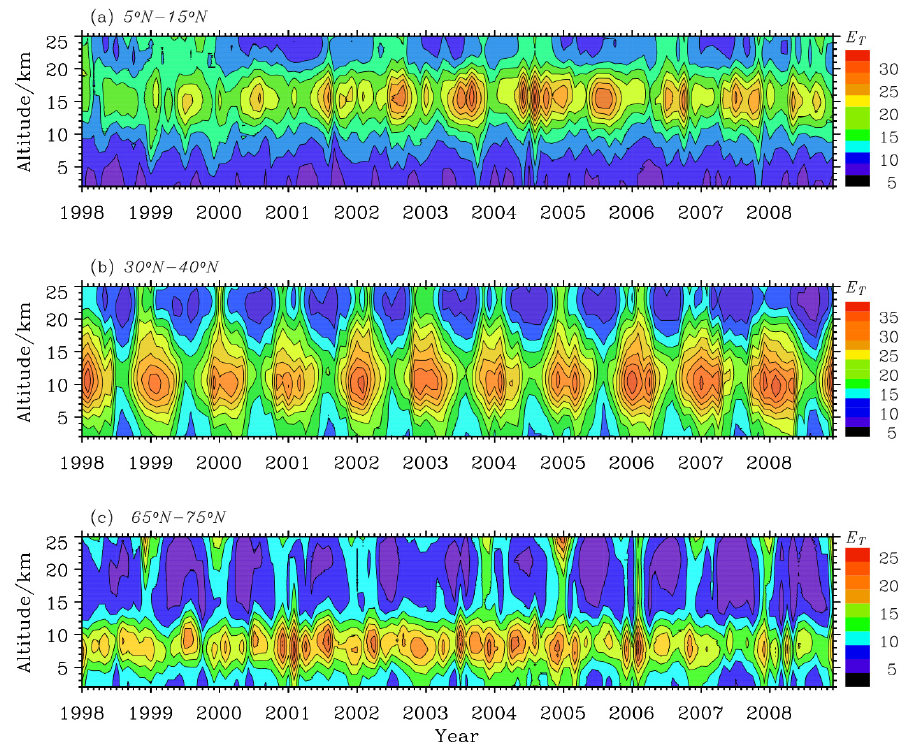
Figure 4. Monthly averaged total gravity wave energy densities (in Jm − 3 ) at low (a) , middle (b) and high (c)